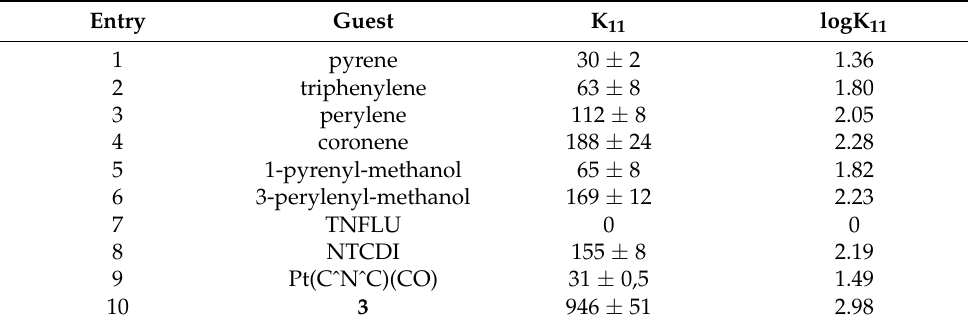
Table 1. Association constants (M − 1 ) for the complexation of 2 with PAHs [a] .